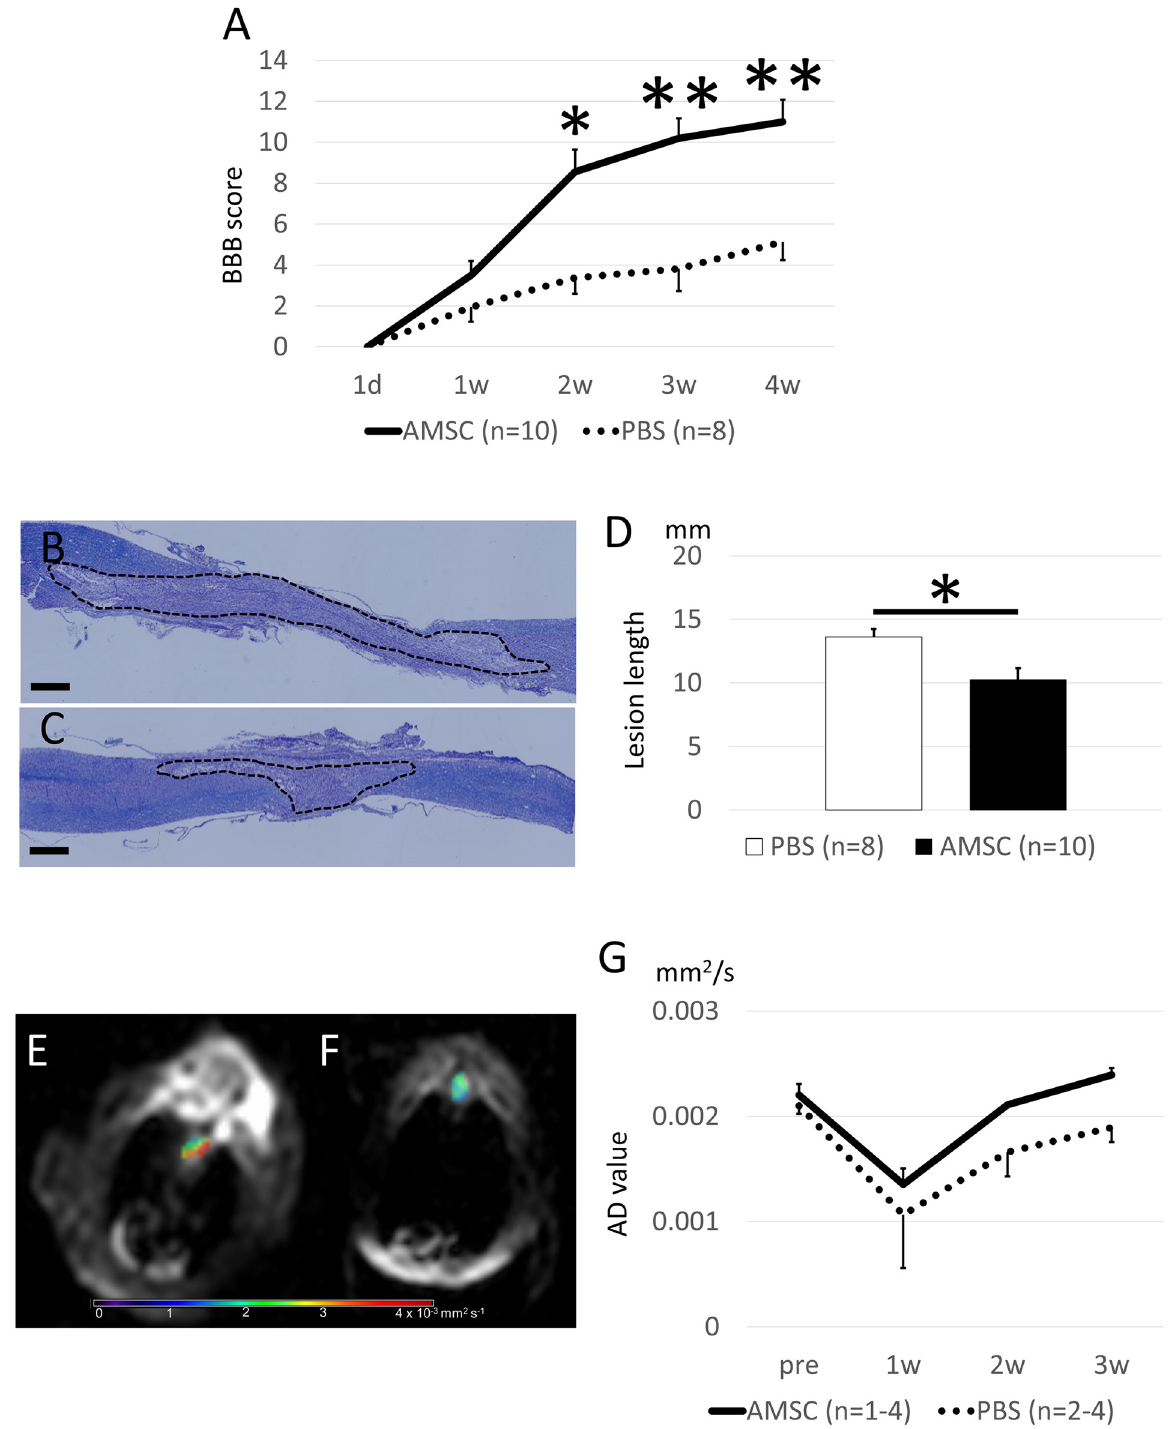
Fig 3. Administration of AMSCs ameliorated the degree of spinal cord damage. (A) Locomotor function was evaluated the next day and weekly thereafter until 4 weeks after the SCI by BBB score. The scores were significantly higher on and after the second week after SCI in the AMSC group compared with the PBS group ( P = 0.0267, 0.0089, and 0.0051, respectively). (B–D) The Kluver-Barrera staining of the spinal cord 4 weeks after SCI showed the degree of spinal cord damage (the dotted area). AMSC Groups (B) and PBS group (C) were evaluated (scale bar: 1 mm). The mean lesion lengths in the AMSC group were significantly shorter than that in the PBS group ( P = 0.0386). (E–G) The spinal cord AD value of the injured lesion was evaluated via diffusion tensor imaging. The representative images of the AMSC group (E) and PBS group (F) are